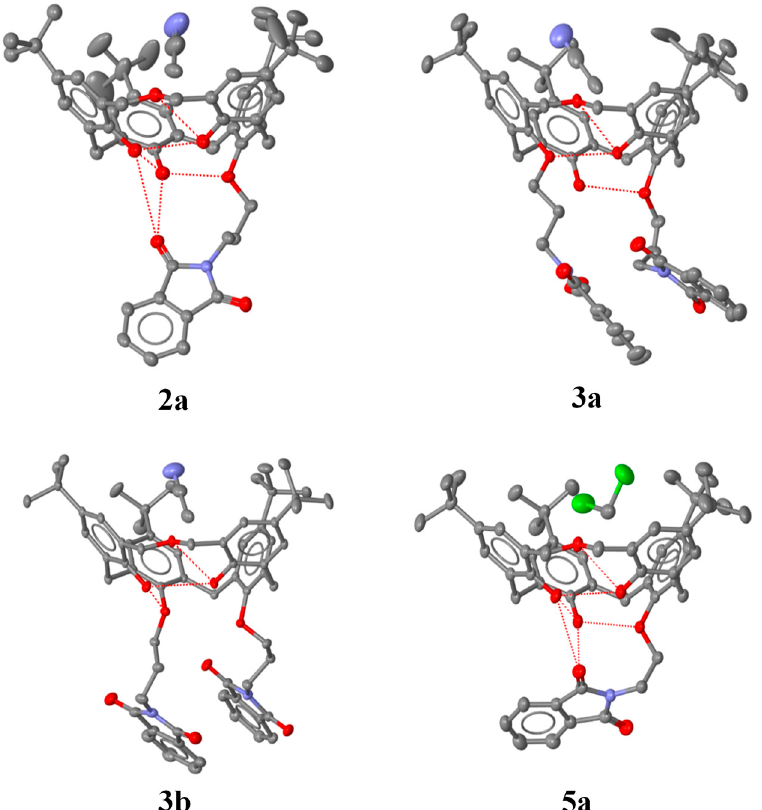
Figure 4. Thermal ellipsoid representations of 2a , 3a , 3b and 5a . Only one of the crystallographically independent molecules is shown for 2a (4 molecules in the asymmetric unit) and for 3a (3 molecules in the asymmetric unit). The atomic species are represented in CPK colors. Ellipsoids are drawn at 50% probability, except for 2a , in which the ellipsoids are represented at 30% probability. Hydrogen atoms, disordered fragments and solvent molecules located outside the calixarene cavities are omitted for clarity.